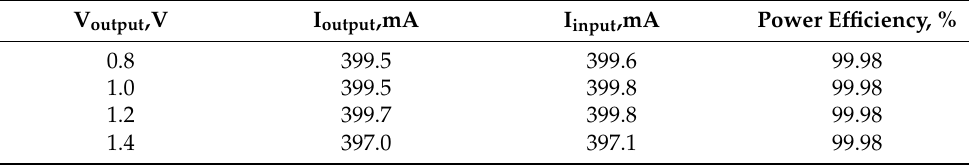
Figure 15. Measured load regulation of proposed MVD-LDO. Current efficiency is an important parameter in LDO regulators as the input and output current are close enough. To evaluate the current efficiency of the regulator, the input current and output current were measured during the full-load condition. Based on the measured results, the current efficiency of the regulator for all four output voltages is computed and displayed in Table 2. Table 2. Current efficiency of proposed